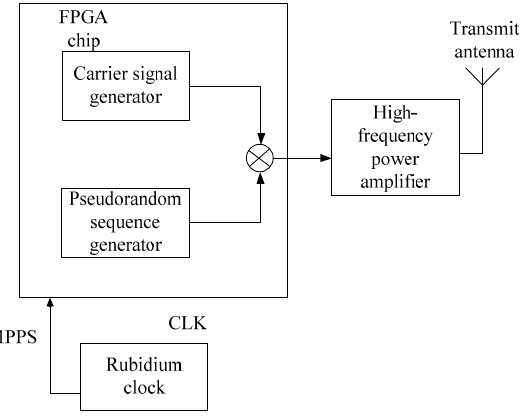
Figure 6. The structure of the baseband signal processing module based on FPGA.